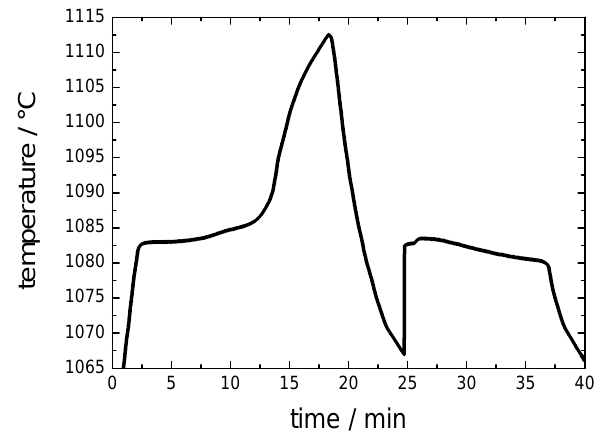
Figure 10. Melt and freeze cycle of a Cu fixed-point cell heated with an induction furnace, wrong inductor position and insu ffi - cient thermal insulation at bottom of crucible. Melting temperature: 1084.62 ◦ C. Measured with the thermal imaging system E-MAqS (Fraunhofer IWS Dresden) with a measuring wavelength of 740nm (compare with typical diagram in Fig. 11).